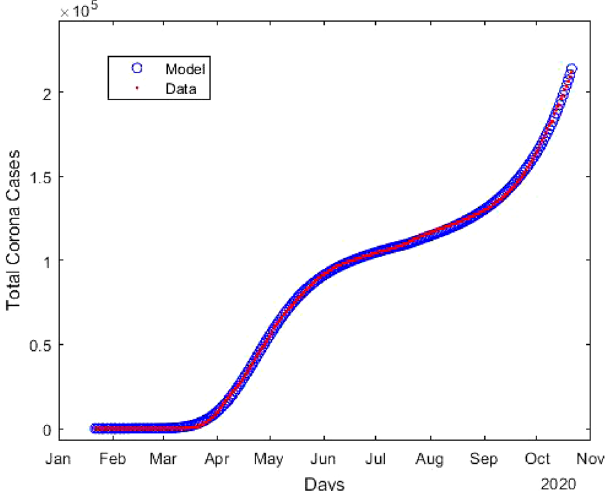
Figure 1. Estimation of the total number of confirmed coronavirus cases ( T ) compared to the available data 28 . Here blue circles indicates the results obtained from model, and red line is the publicly available data 28 .